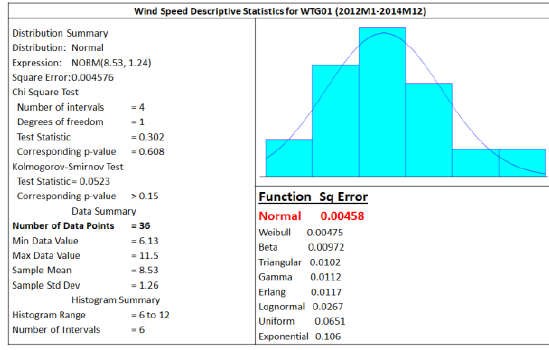
Figure 1. Research stages and framework